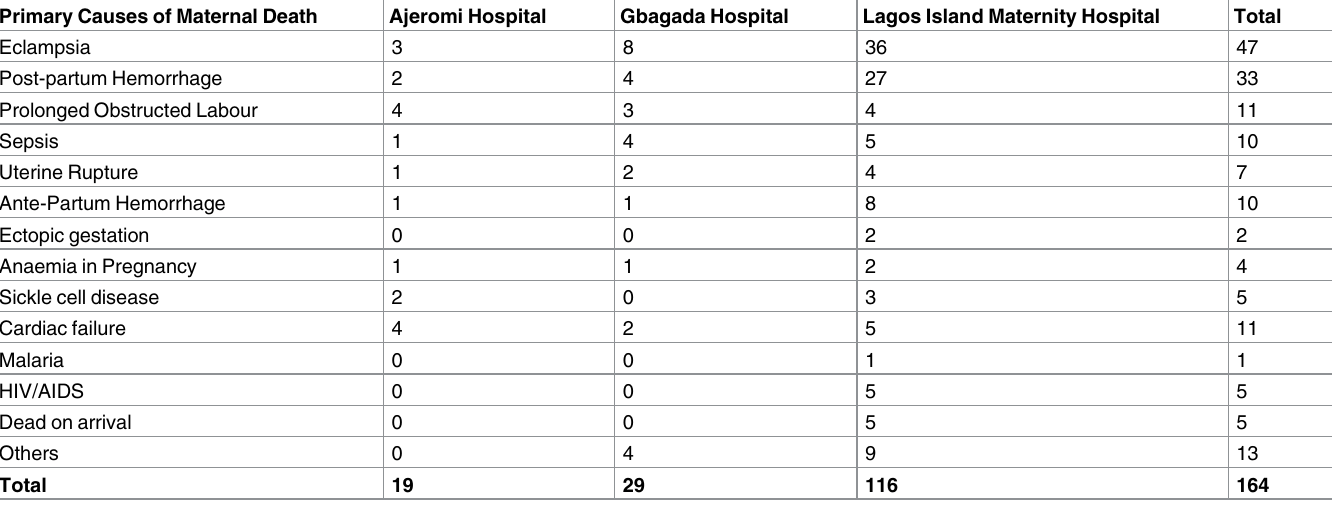
Table 3. Medical causes (primary causes) of maternal deaths by health facilities.